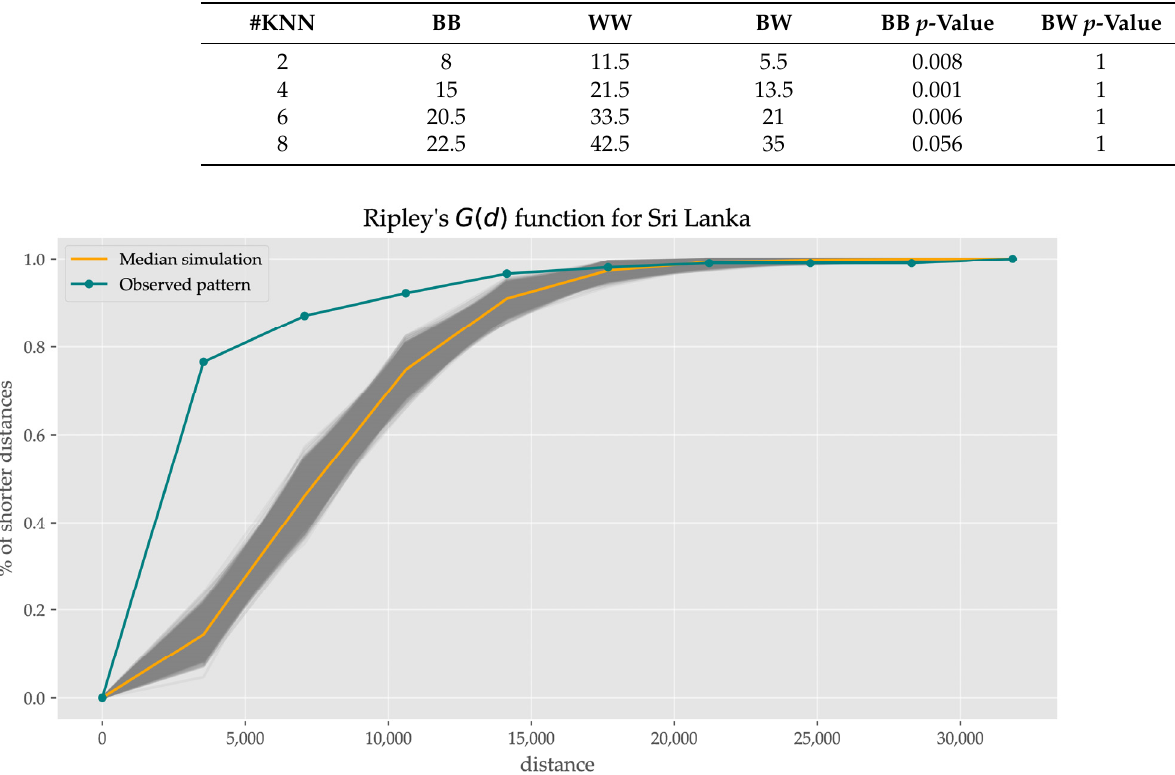
Table 9. Joint count statistics for spatial autocorrelation in Sri Lanka.